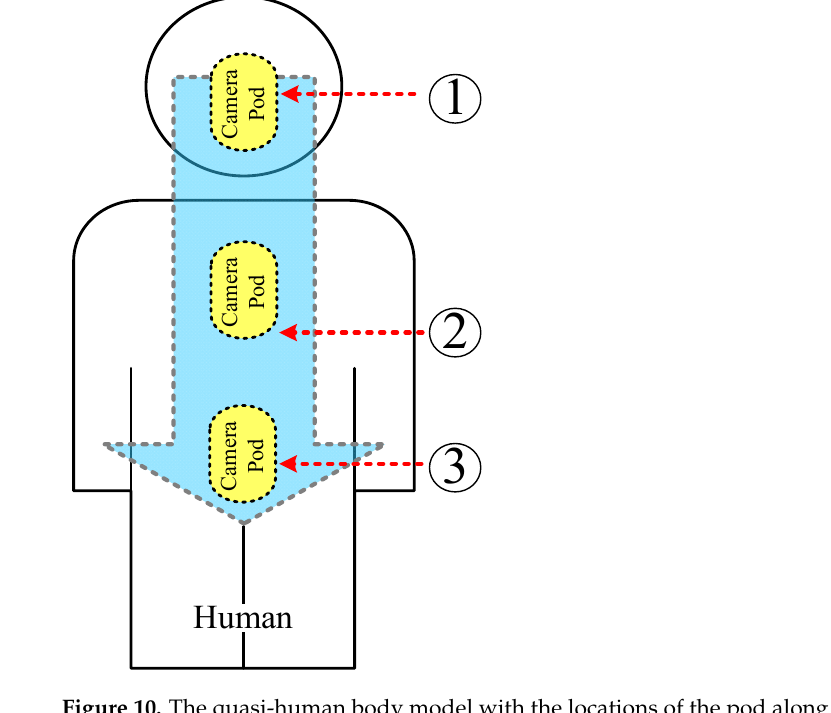
Figure 10. The quasi-human body model with the locations of the pod along the digestive system, where 1, 2, and 3 denote the throat, stomach, and intestine.